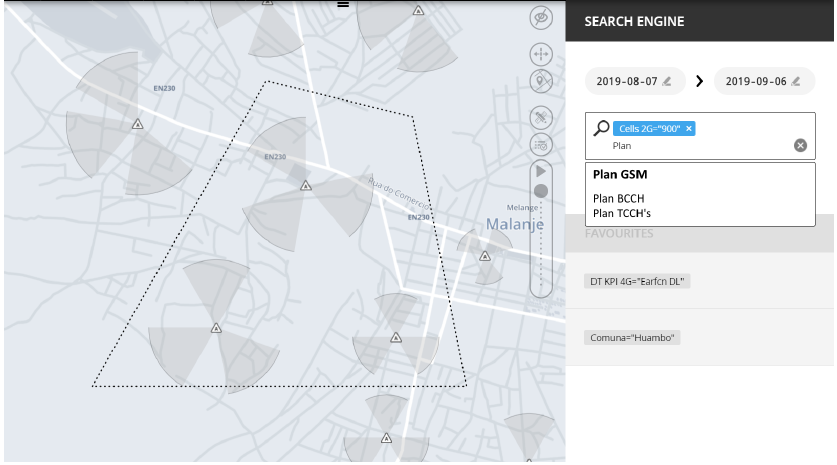
Figure 12. Frequency allocation request in Metric SaaS.